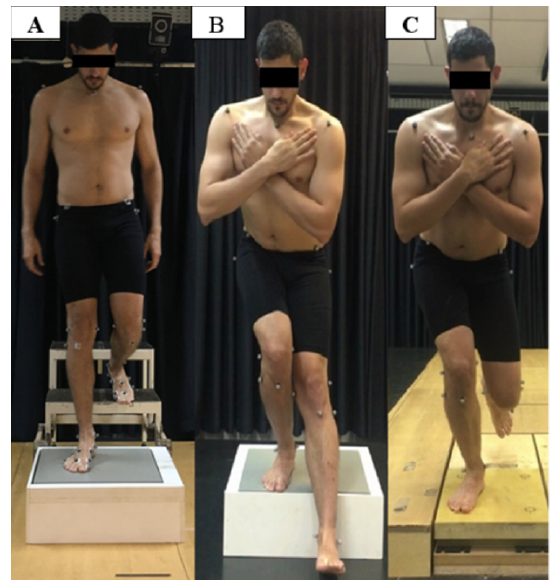
Figure 1. Single-leg support tasks: step descent ( A ), single-leg step down ( B ), and single-leg squat ( C ).